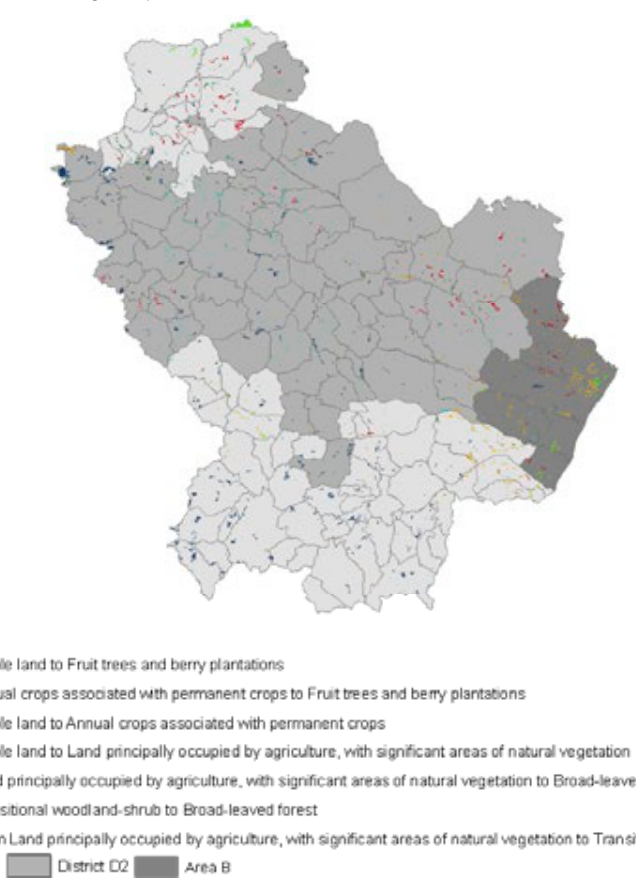
Figure 3. Land use change map: “Baseline”